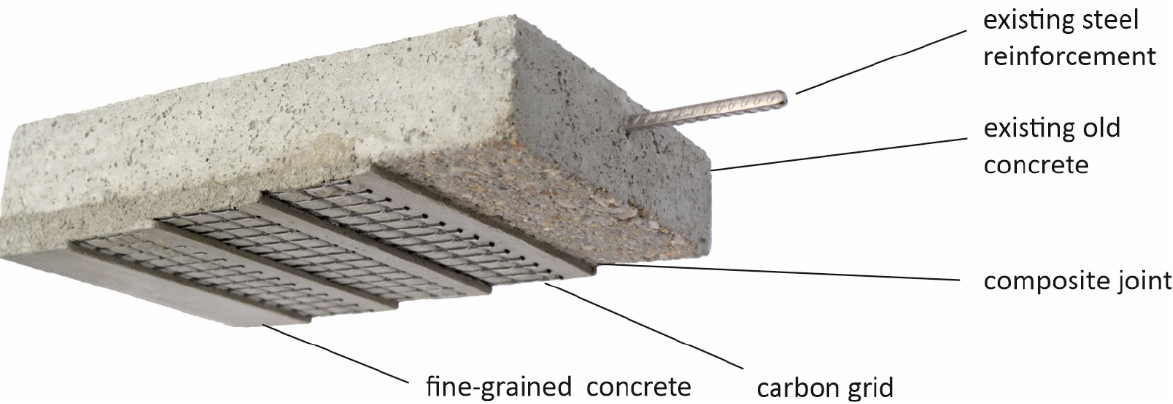
Figure 2. Exemplary structure of a strengthening with carbon reinforced concrete. (Photo: TU Dresden).